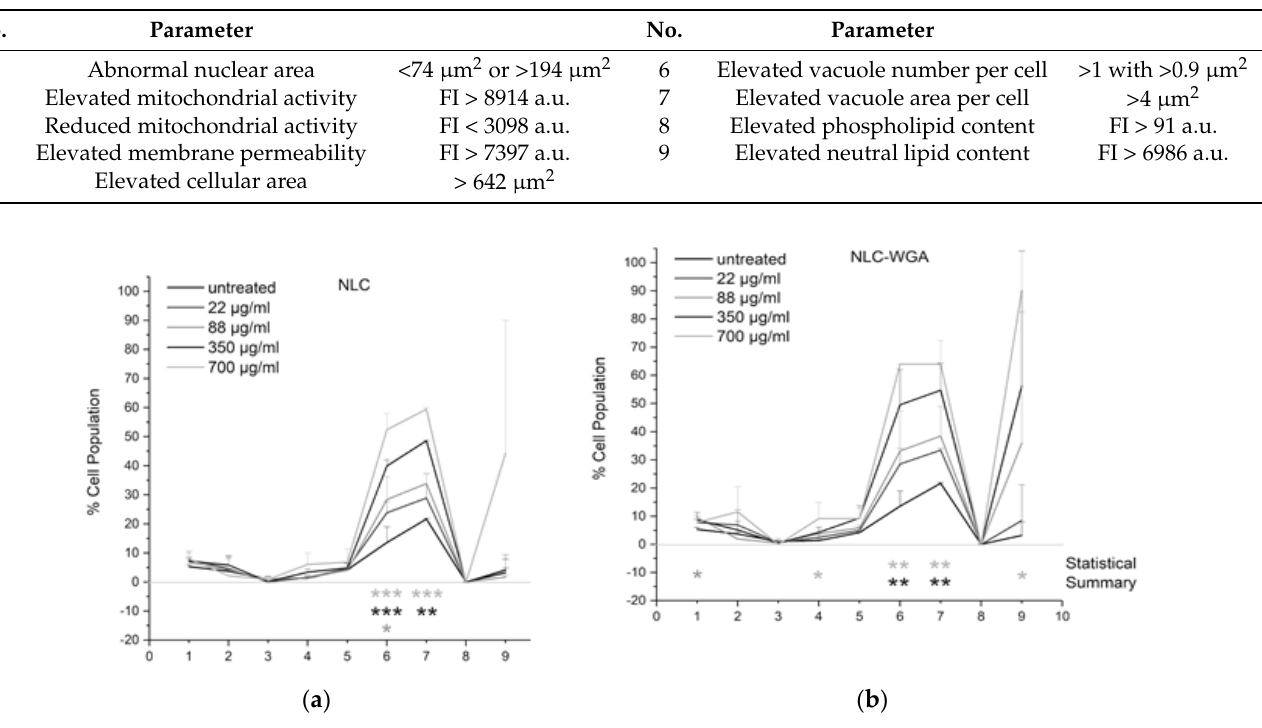
Table 5. Values above or below the ones stated for each parameter were considered abnormal.